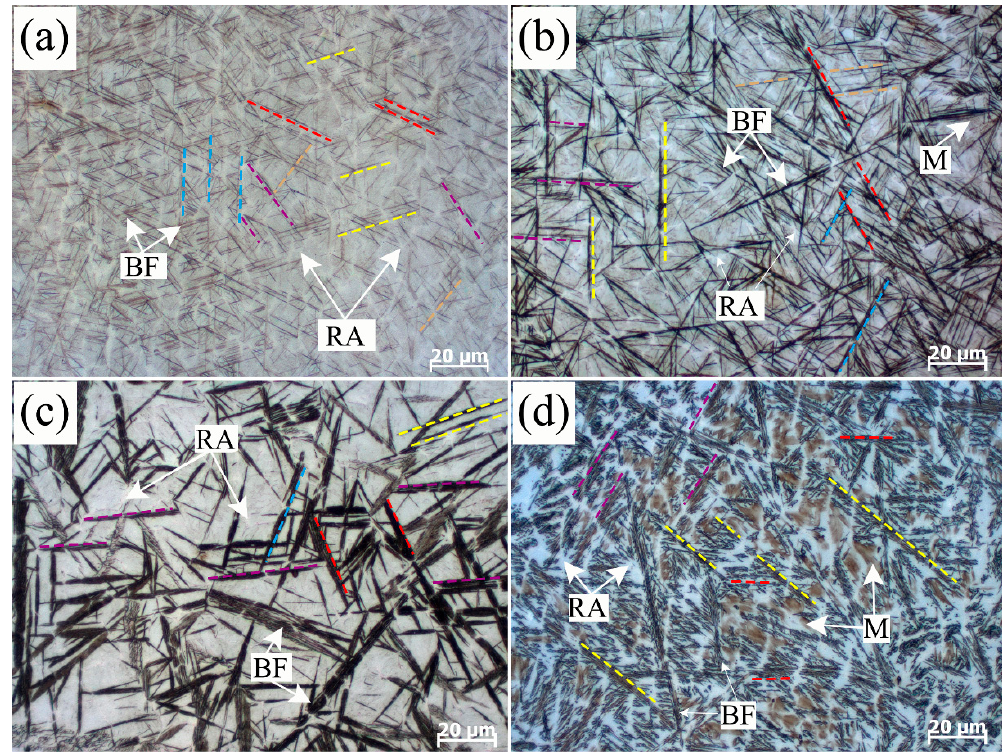
Figure 1. Optical micrographs of the nanobaninitc coatings after different isothermal processing at 200 °C for 4 h ( a ); 250 °C for 2 h ( b ); 300 °C for 2 h ( c ); and 350 °C for 3 h ( d ).